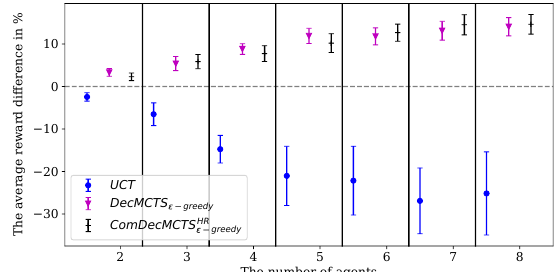
Figure 16. The performance comparison of algorithms in percentage over all warehouse problems. The 0 represents the method of Claes et al. The whiskers show the standard error.